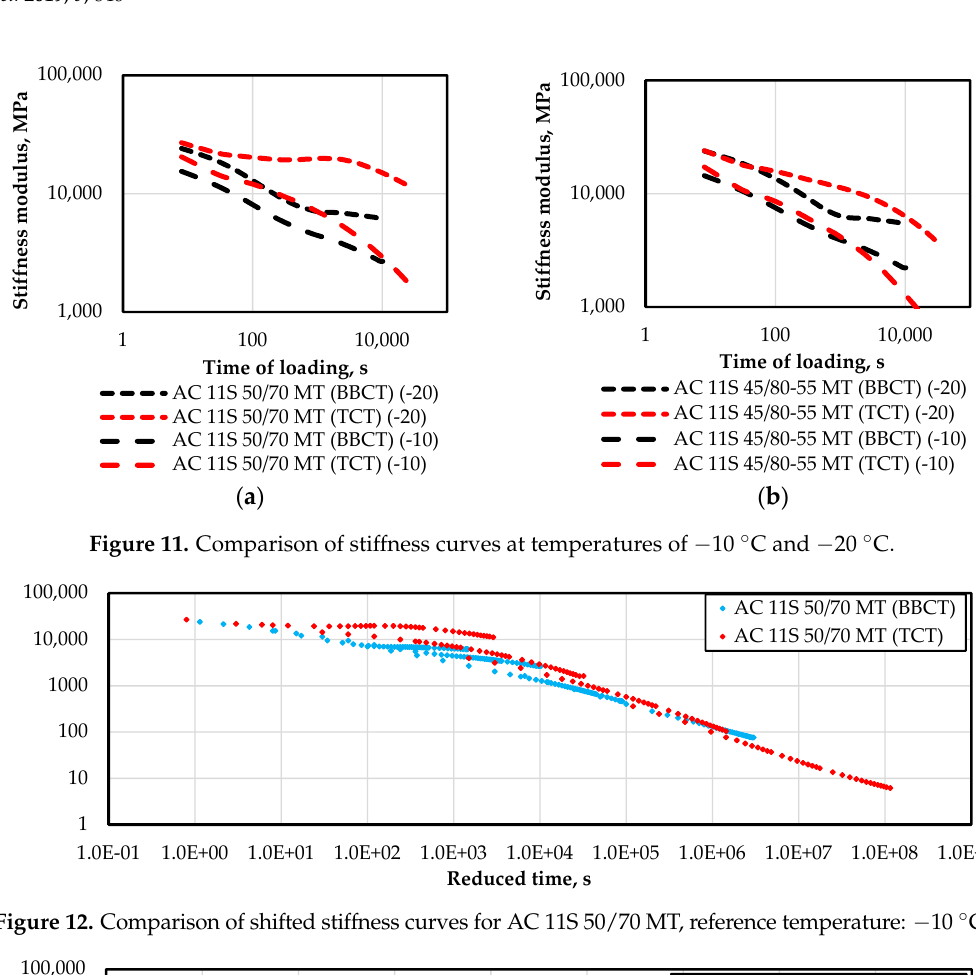
Figure 12. Comparison of shifted stiffness curves for AC 11S 50/70 MT, reference temperature: − 10 °C.